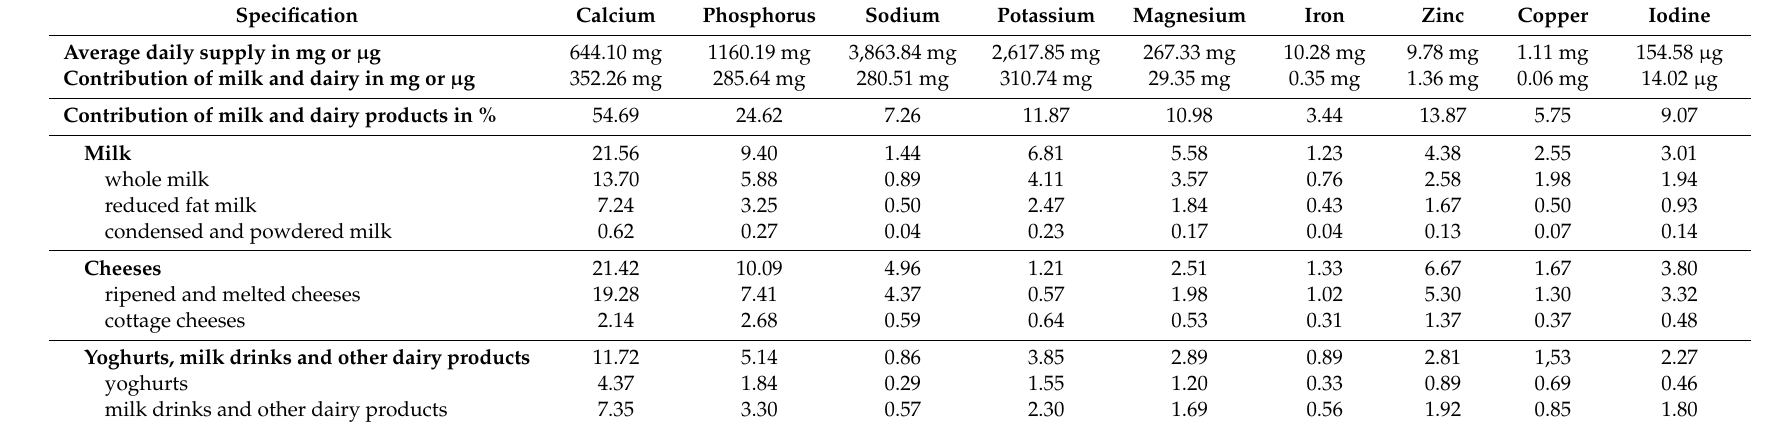
Table 6. Dairy sources of minerals contribution to the average Polish diet (in mg or µ g and %).